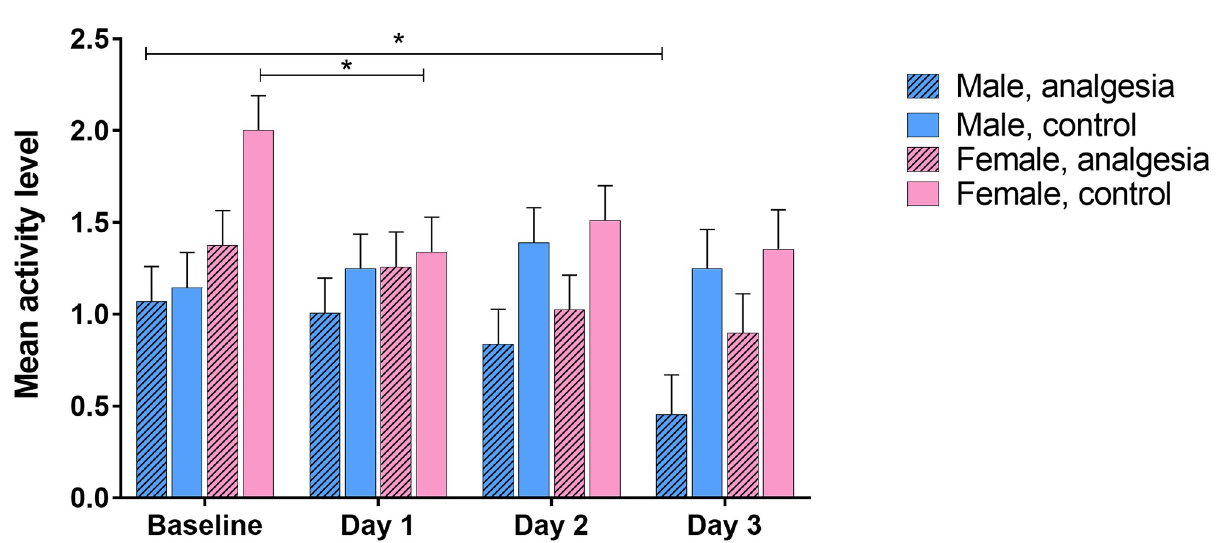
Fig 6. Activity level by day of experiment, sex, and analgesia treatment. Bars with asterisks indicate differences between categories (Tukey < 0.05). Data were square root transformed for analysis; y-axis is back-transformed. Activity level is a linear measurement from 0 to 3; higher values indicate higher levels of activity. Data presented are LSM and